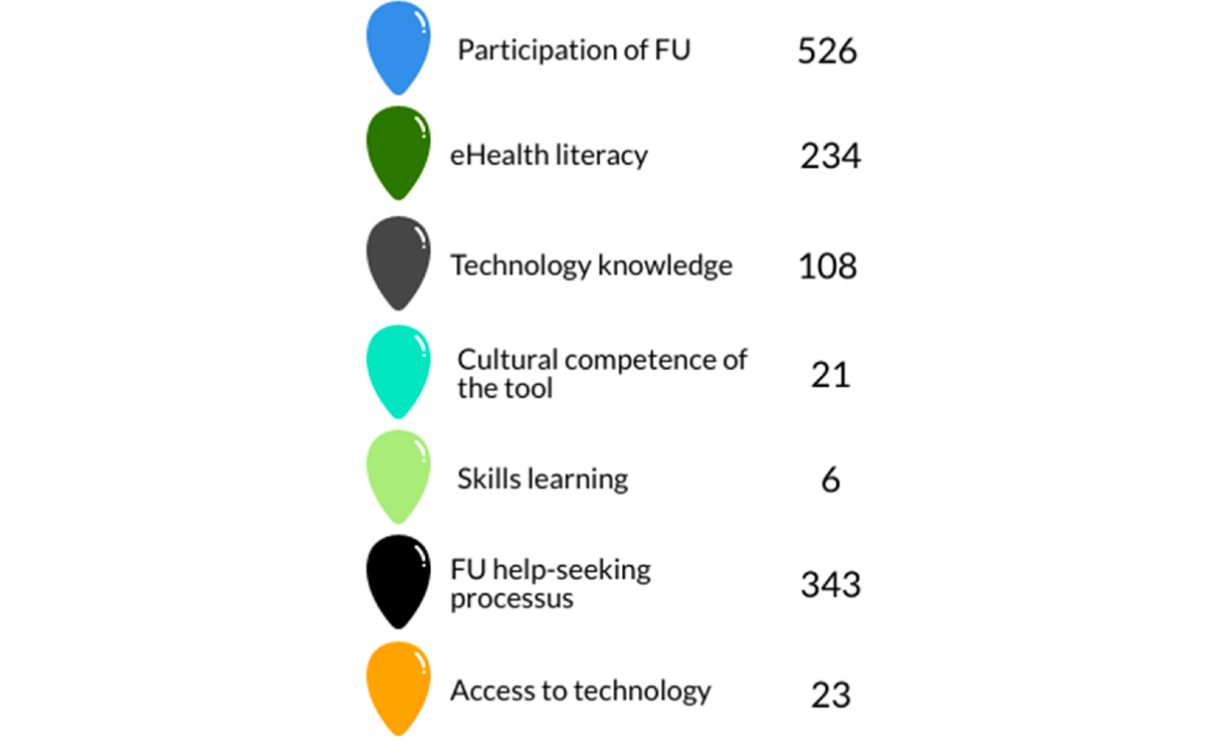
Figure 3. Code list. FU: Future